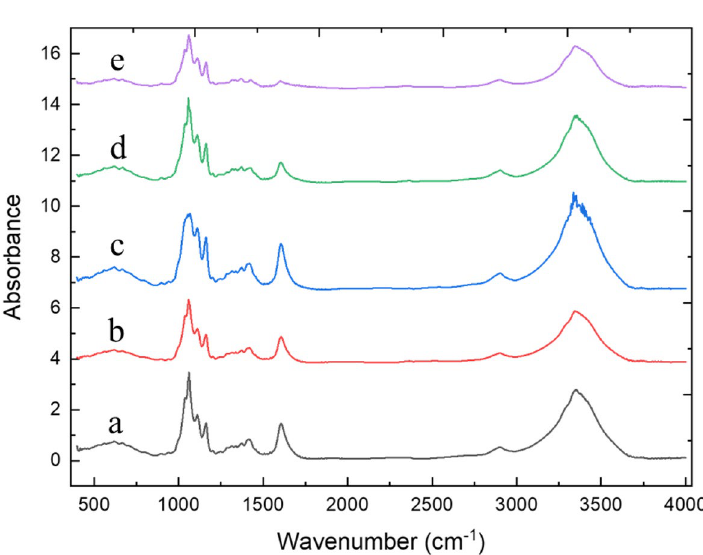
Figure 4. FT-RI spectrum of a 15-μm-thickness film sample made by using the as-produced TEMPO-CNFs (a) or the heated TEMPO-CNFs in 135 °C (b), 140 °C (c), 150 °C (d), or 160 °C (e) saturated water vapor, respectively, for 2 h. The film samples were measured directly (without